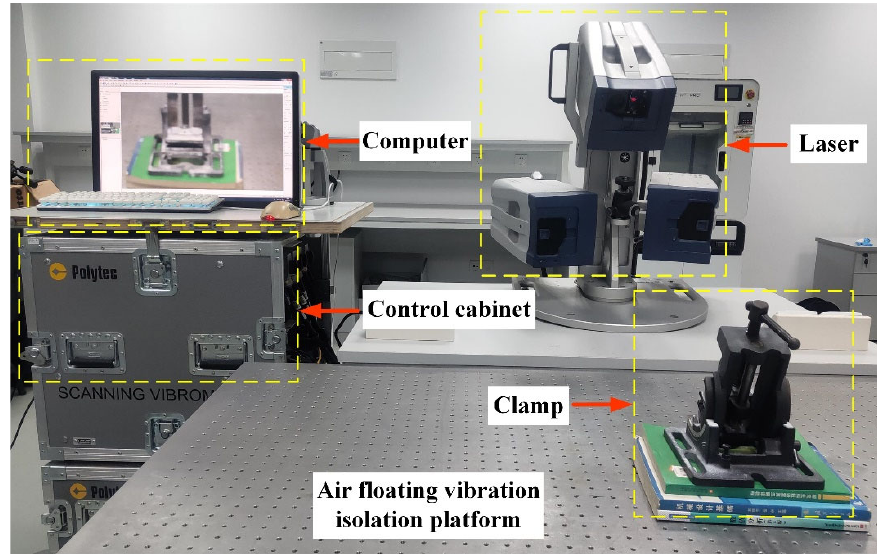
Figure 6. The contribution rate of basis functions.